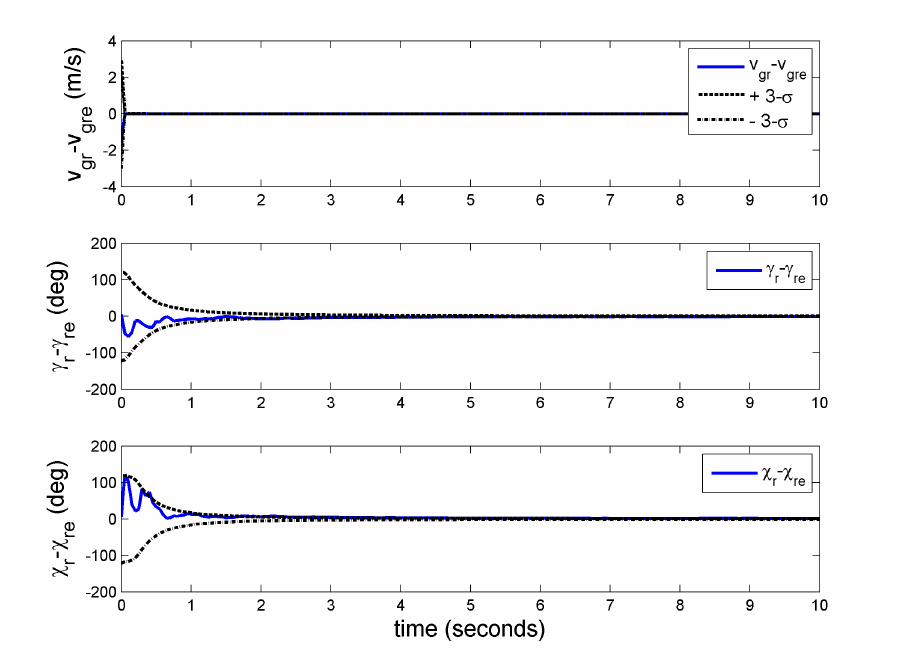
Figure 3. Speed, flight path angle and heading angle errors (true-estimated) with 3 − σ bounds for target (Case